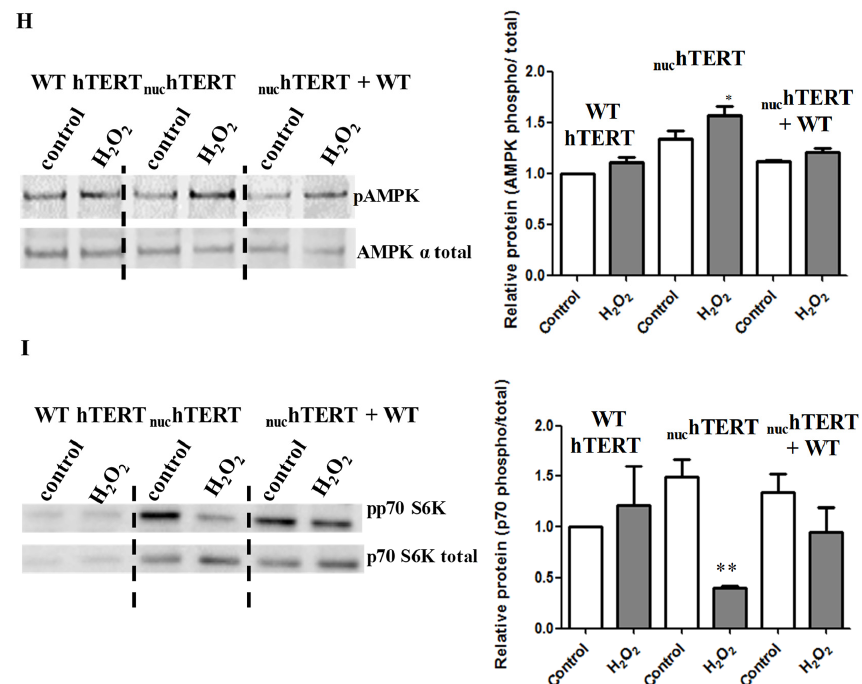
Figure 2. Autophagy is upregulated upon oxidative stress but only when hTERT does not enter mitochondria. ( A ) WT hTERT and nuc hTERT were submitted to 60 min of 200 µ M H 2 O 2 treatment and allowed to recover in conditioned medium for 24 h. The cells were then harvested and assayed with Yopro-1 and propidium iodide to monitor apoptosis (YoPro-1) and cell death (propidium iodide) using flow cytometry. Graphs depict the mean of at least three biological experiments ± SEM. Student t -test was performed by comparing each corresponding cell death marker to its representative control. p value < 0.05 *. ( B ) WT hTERT and nuc hTERT cells were subjected to 200 µ M of H 2 O 2 for 60 min (0 h), and allowed to recover at two, six, and 24 h. After the removal of H 2 O 2 the cells were cultured in conditioned medium (medium in which cells had grown overnight containing cells released-growth factors) for the two, six, and 24 h recovery time points. Levels of beclin were normalized to actin. Graph represents the average of eight independent experiments ± SEM. Student t -test was performed by comparing each treated sample — 60 min H 2 O 2 and the recovery time points to its respective control (untreated cells). Statistical significance was determined at p value < 0.05 * and 0.01 **. (C) LC3-II levels were assayed by immunoblots following H 2 O 2 treatment in WT hTERT and nuc hTERT expressing cells. The levels of LC3-II were normalized to actin. Graph shows average of 8 independent experiments ± SEM. Student t -test was performed by comparing each 60-minute H 2 O 2 treatment to its respective untreated control. Statistical significance was p value < 0.01 **. ( D – E ) Representative Western blot analysis of extracts from cells (WT hTERT and nuc hTERT) untreated (control) and treated (200 µ M H 2 O 2 for 60 min) against phospho AMPK α (Thr172), AMPK α total, phospho p70S6K (Thr389) and p70S6K total antibodies . Graphs show average data from four independent experiments ±